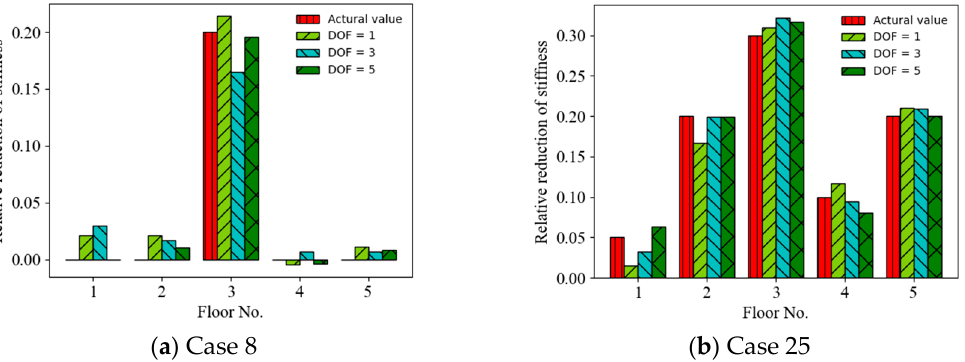
( b ) Case 19 Figure 10. MSEs of prediction values versus time length using acceleration and displacement re- sponses as ANN input. 4.4. Effect of Limited Measurement Points The effect of the random vibration responses measured from the limited measure- ment points on the accuracy of the ANN-based SAD method was investigated. Three cases of limited measurement points were considered as follows: (1) the random vibra- tion responses were measured from one measurement point (first floor) (DOF = 1); (2) the random vibration responses were measured from three measurement points (first, third, and fifth floors) (DOF = 3); and (3) the random vibration responses were measured from five measurement points (all floors) (DOF = 5). Figure 11 shows a comparison of the pre- diction results (mean values of relative stiffness reduction) (Cases 8 and 25) using the acceleration responses measured from different measurement points as the ANN input (with a 20 dB SNR). It can be observed that the accuracy of the prediction results roughly increased with the number of the limited measurement points from 1 DOF to 5 DOF. For example, the MSEs of the prediction values are 2.55 × 10 − 4 , 4.98 × 10 − 4 , and 4.18 × 10 − 5 for 1, 3, and 5 measurement points, respectively, in Case 8. Figure 12 shows a comparison of the prediction results (mean values of relative stiffness reduction) (Cases 8 and 25) using displacement responses measured from different measurement points as the ANN input